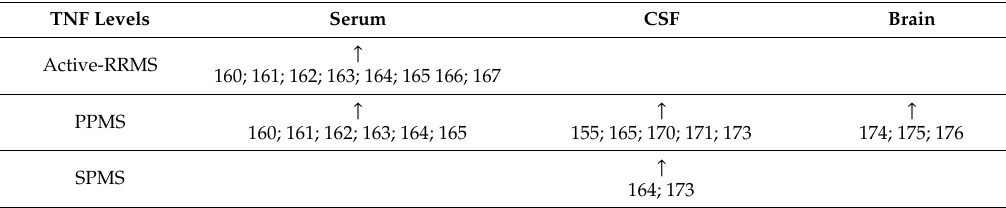
Table 2. TNF levels in MS